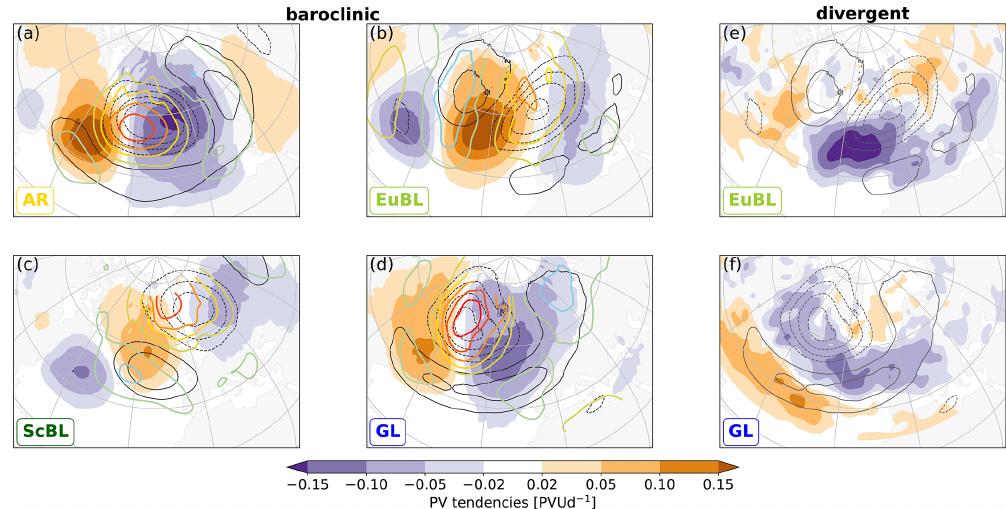
Figure 6. Same as Fig. 5, but for baroclinic coupling for AR (a) , EuBL (b) , ScBL (c) , and GL (d) and the divergent tendencies – EuBL (e) and GL (f) . Note the different color bar compared to Fig. 5. Colored contours in (a) – (d) denote potential temperature at 850hPa, warm colors for positive and cold colors for negative values, with a contour interval of 1K, omitting the zero line.